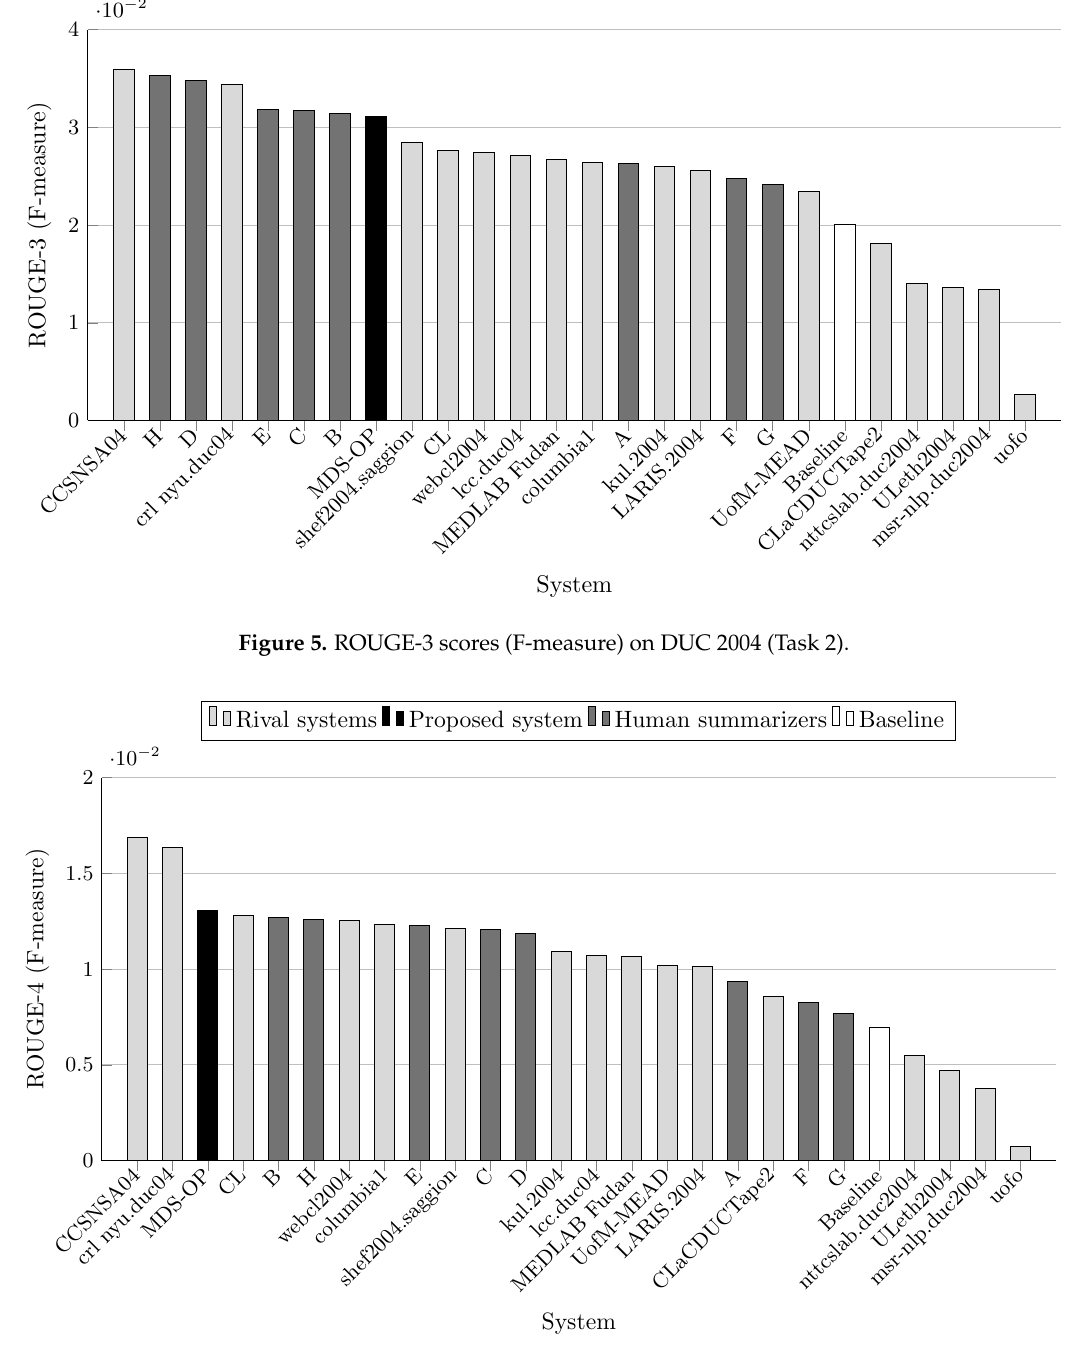
Figure 6. ROUGE-4 scores (F-measure) on DUC 2004 (Task